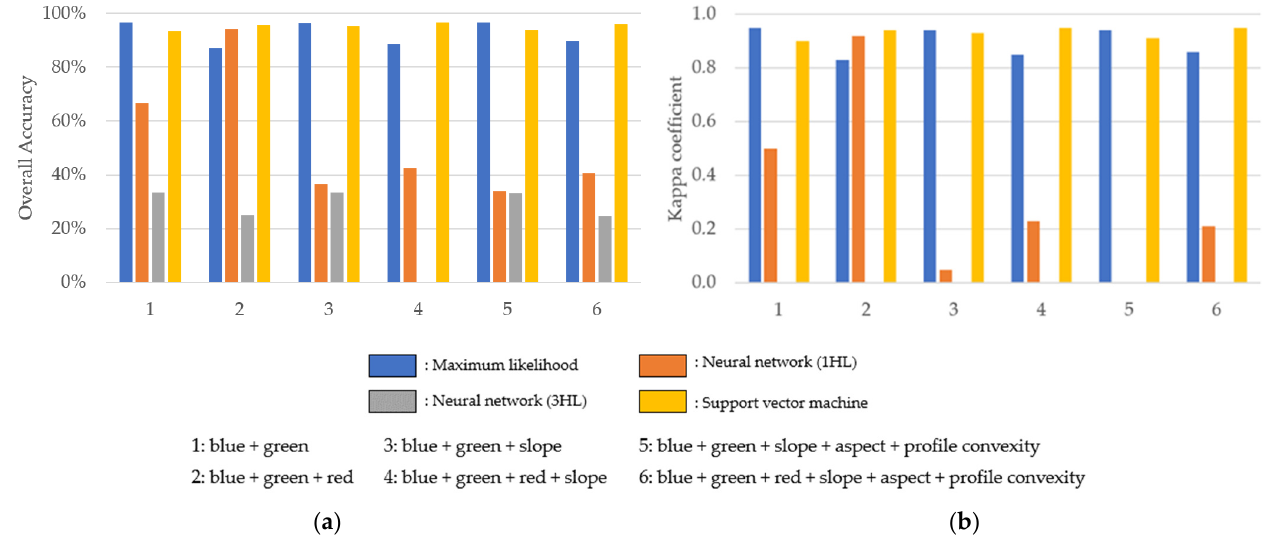
Figure 10. Performances of the different classifiers using different geomorphological predictors. ( a ) Overall accuracy; ( b ) Kappa coefficient.